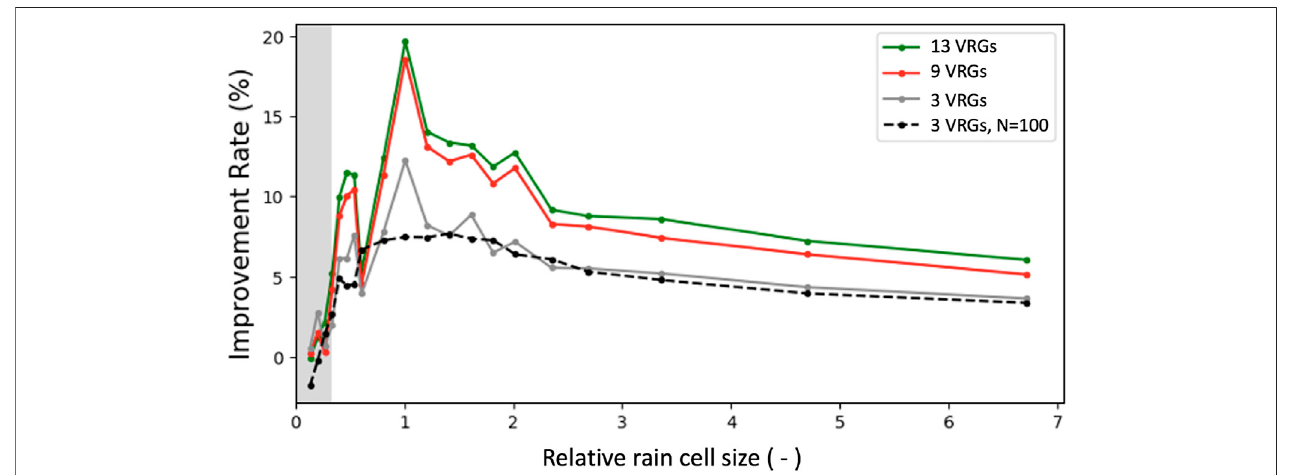
FIGURE1| From Eshel et al.(2020) — RMSE improvement rate ofcases where GMZ wasapplied insimulationswhere 3,9, and 13VRGs wereassigned per CML, relative to the RMSE of the case of a single VRG per CML without GMZ. Results are plotted against the rainfall cell size normalized by the average length of CMLs in the network.Asimulationwithalargerdataset,solelyforthecasewhereGMZwasappliedwiththreeVRGsperCML,isdisplayedaswell(dashed).GMZconstantlyimproves RMSE performancebut hasnegligibleadditional contribution when more thannine VRGsare used.Thegrey shading markstheareawherethe reconstruction and the ground truth had a correlation coef fi cient < 0 . 6, indicating that the rain GRC was too small to monitor. The number of links was generated (approximately 130) for a link density of 0.53 km − 2 in an area of 16 km 2 × 16 km 2 .